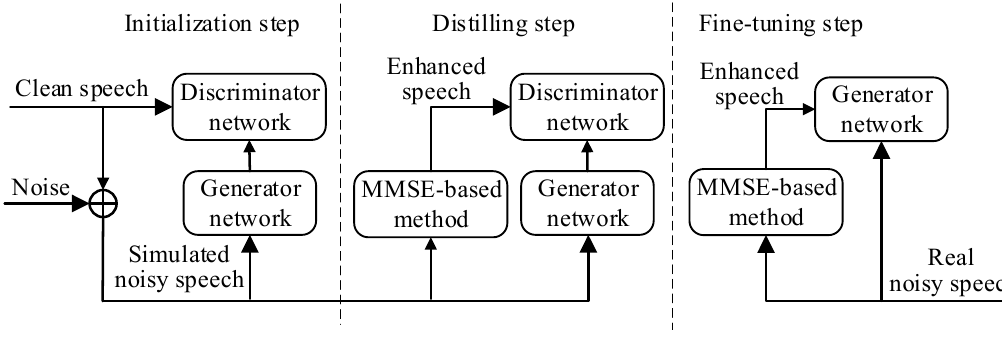
Figure 3. The framework of the proposed algorithm.